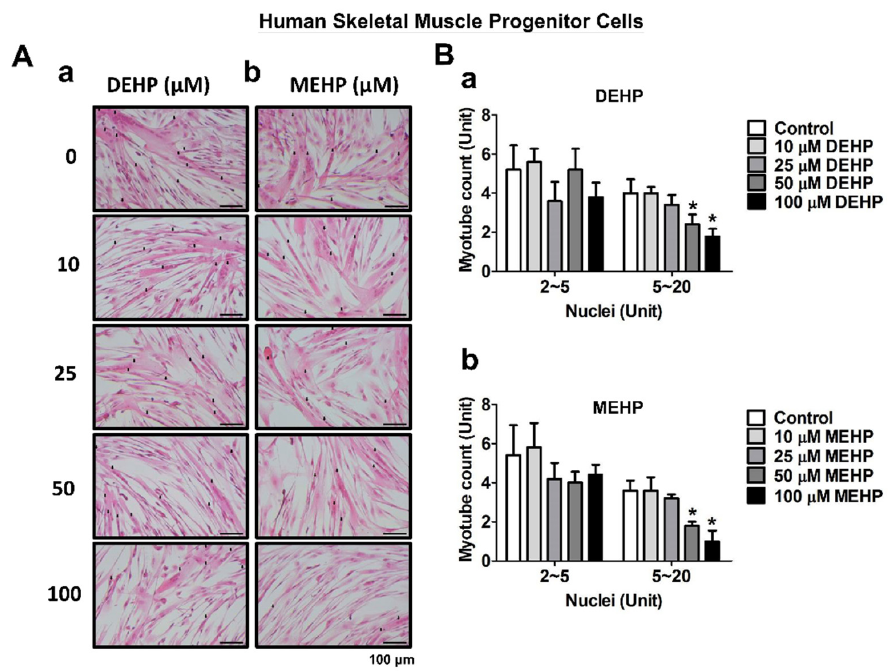
Figure 5. The changes in myotube formation in primary HSMPCs treated with both DEHP and MEHP. Under differentiation medium, HSMPCs treated with DEHP ( Aa , Ba ) or MEHP ( Ab , Bb ) (10–100 µ M) for 96 h were observed. The cell morphology ( A ) was shown and the myotube formation ( B ) was counted (nuclei number per myotube). Data are presented as means ± SEM (three independent experiments, triplicate repeats in each); p < 0.05 indicates significance compared to the control